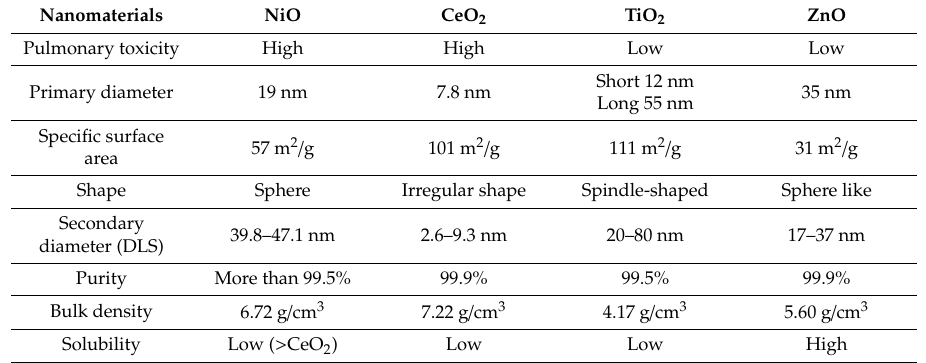
Table 1. Physiochemical characterization of the nanomaterials used in the present